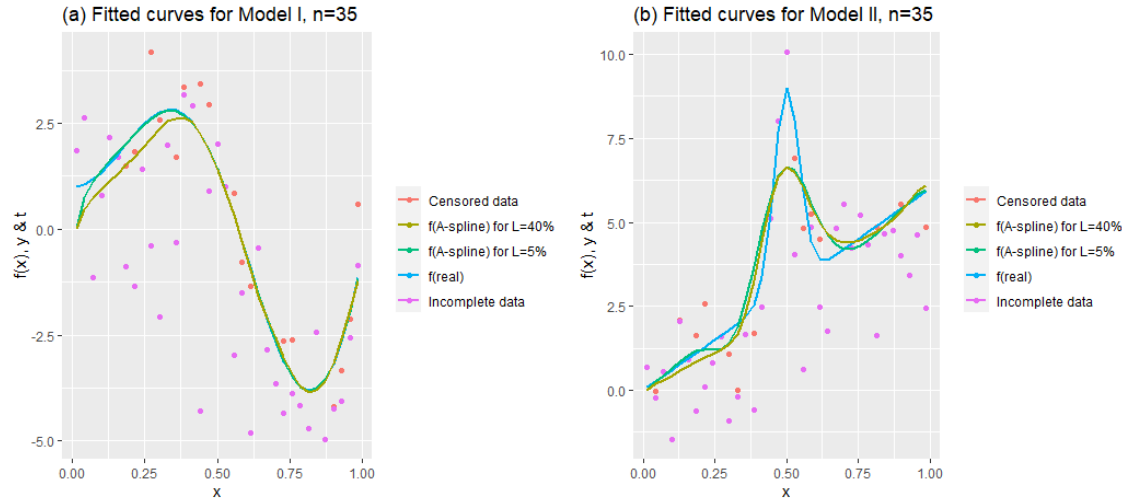
Figure 2. Fitted curves to see the performance of the estimator for n = 35, L = 5%, 40%.